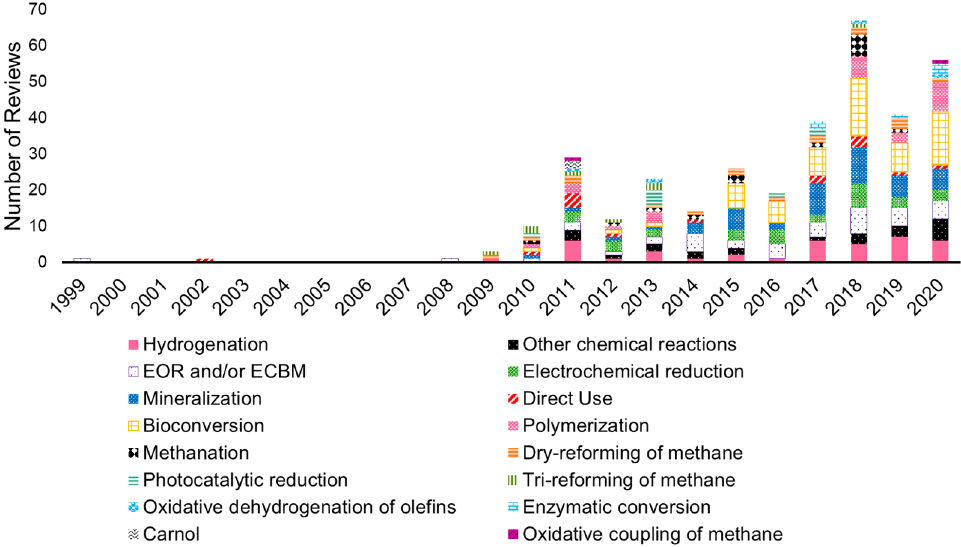
Figure 23. Frequency distribution of citations of carbon dioxide transformation processes through the